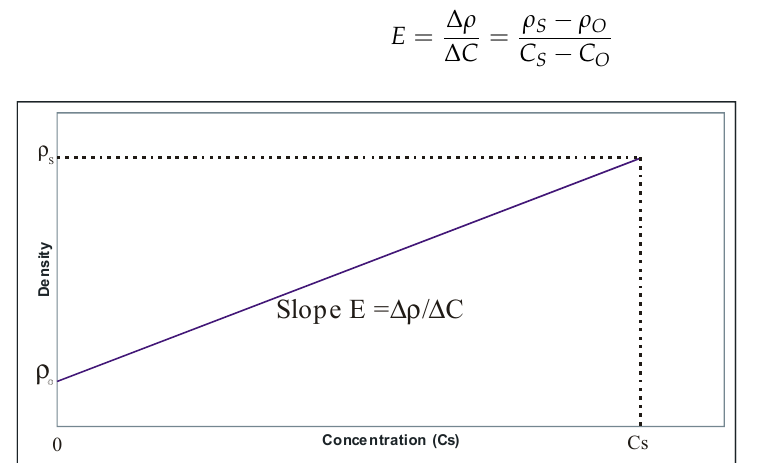
Figure 2. A general linear relationship between fluid density and salt concentrations.